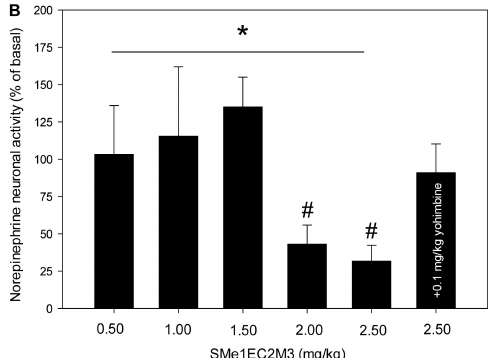
Figure 4. E ff ect of SMe1EC2M3 on the excitability of norepinephrine neurons of the locus coeruleus. ( A ): representative recording from a single neuron; ( B ): summary result from seven neurons from seven rats, expressed as % ± SEM of basal activity. SMe1EC2M3 was applied at the cumulative doses of 0.5–2.5 mg / kg (i.v.). Two minutes after the last SMe1EC2M3 administration, a selective antagonist of / kg, i.v.); * p < 0.05, one-way ANOVA for repeated α 2 adrenoceptors, yohimbine, was injected (0.1 mg measures; # p < 0.05, Fisher´s LSD post-hoc test.